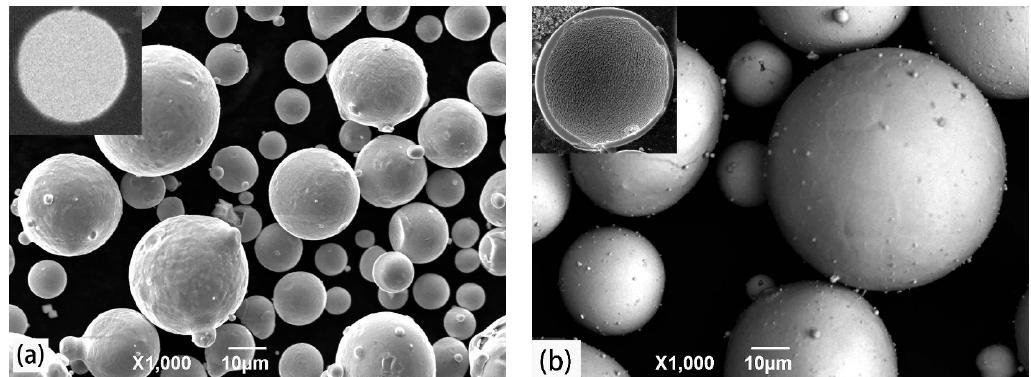
Figure 1. SEM images of powders: ( a ) CoNiCrAlY powder for the bond coat; ( b ) yttria-stabilized zirconia (YSZ) powder for the ceramic topcoat. The inset in ( b ) exhibits the hollow feature of the YSZ powder by the cross-section.